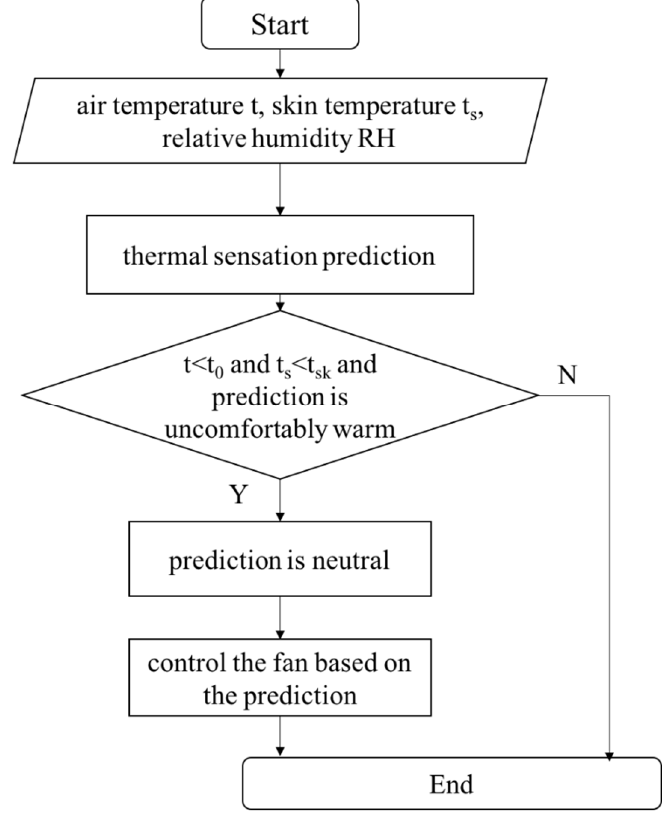
Figure 7. An example of updating the personal comfort model. Technologies 2021 , 9 , 90